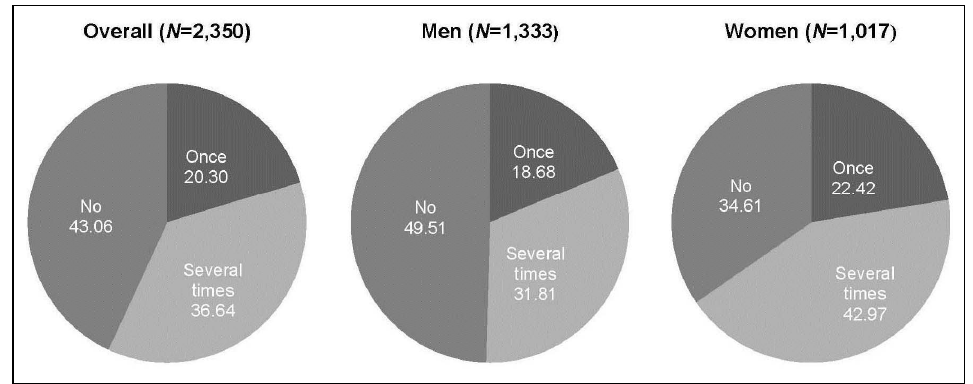
Figure 3 : Pie charts of experienced deception (Percentages). Question: “Have you ever been in contact with somebody on an online dating site who lied in his/her online